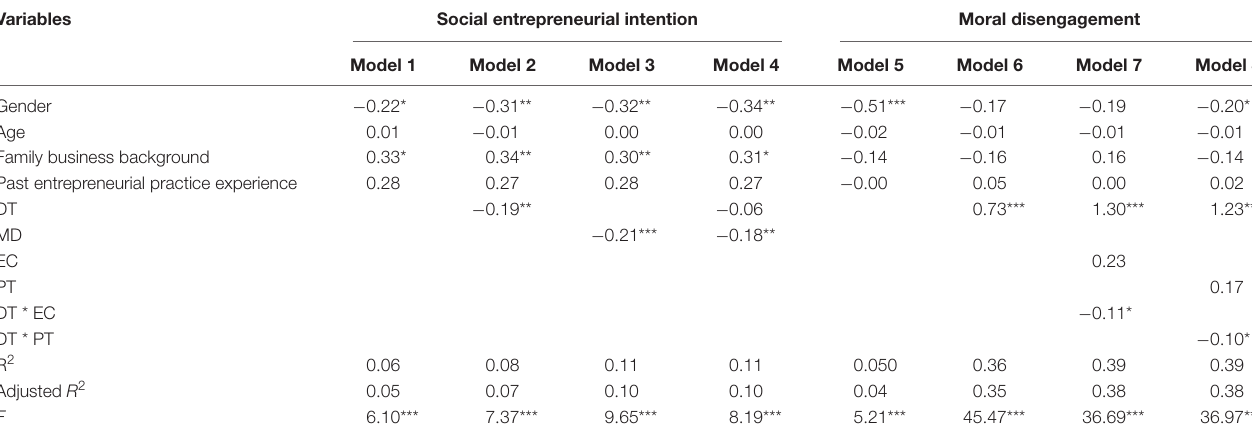
TABLE 5 | Results of multiple regression analysis in Study